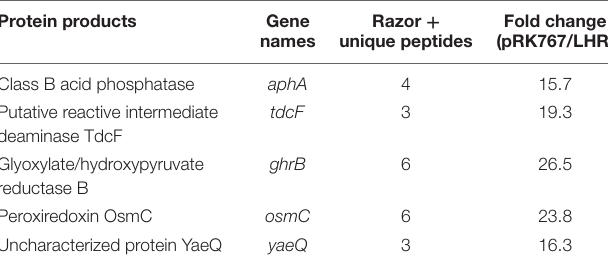
(pRF1) had also fewer protein aggregates compared to E.